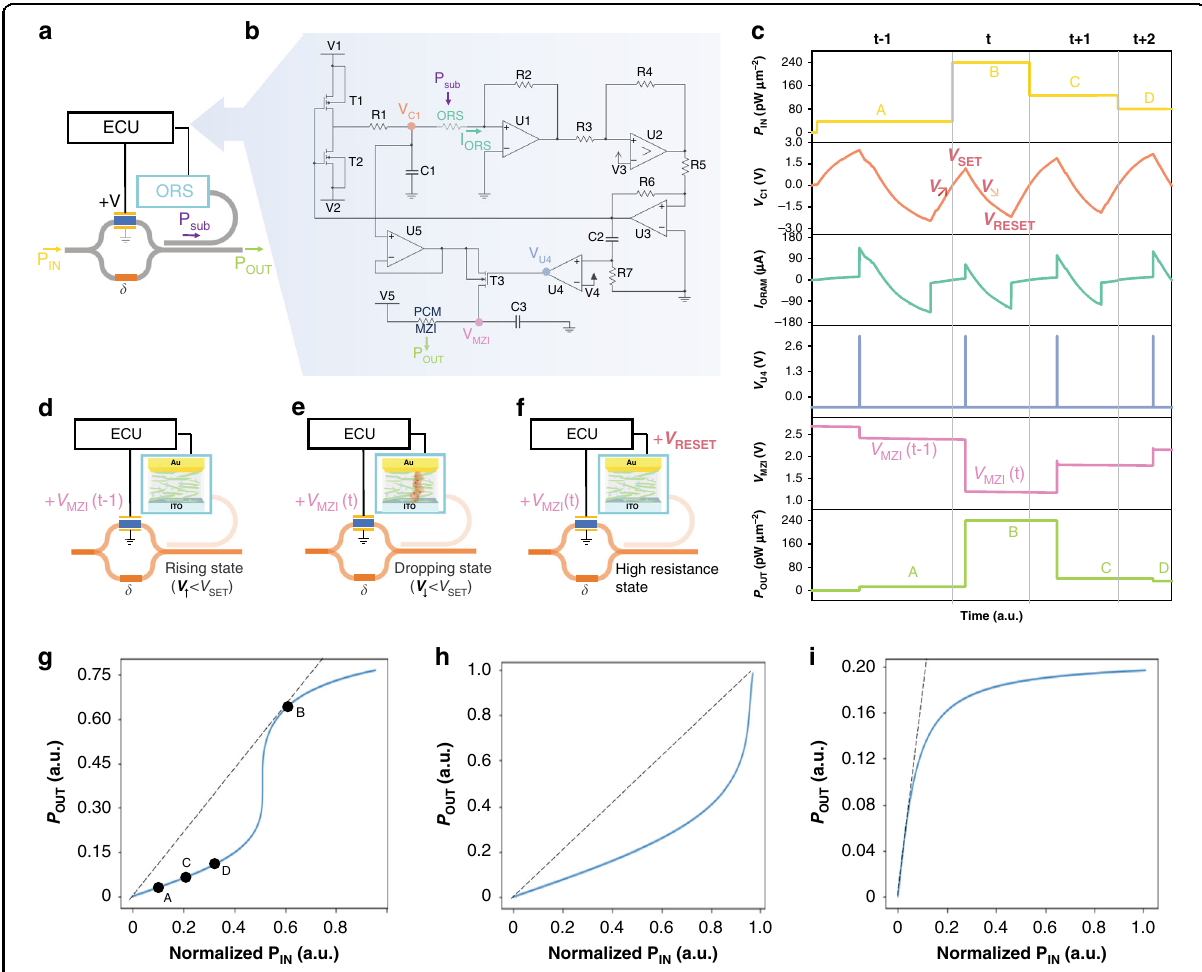
Fig. 4 Accelerator structure and function. a Simpli fi ed schematic of the proposed nonlinear accelerator, corresponding to Fig. 1b. b Circuit diagram of electrical control unit with marked nodes. c Time-series diagram of data obtained in marked nodes over 4 cycles. d – f Working states in nonlinear accelerator at ( d ) rising state, e dropping state and ( f ) high resistance state. g – i Nonlinear activation functions output transmission power as a function of normalized input signal power. g – i correspond to sigmoid, softplus and clamped ReLU responses respectively. (ORS Opto-Resistive RAM Switch, ECU Electrical Control Unit, MZI Mach – Zehnder Interferometer, PCM Phase Change